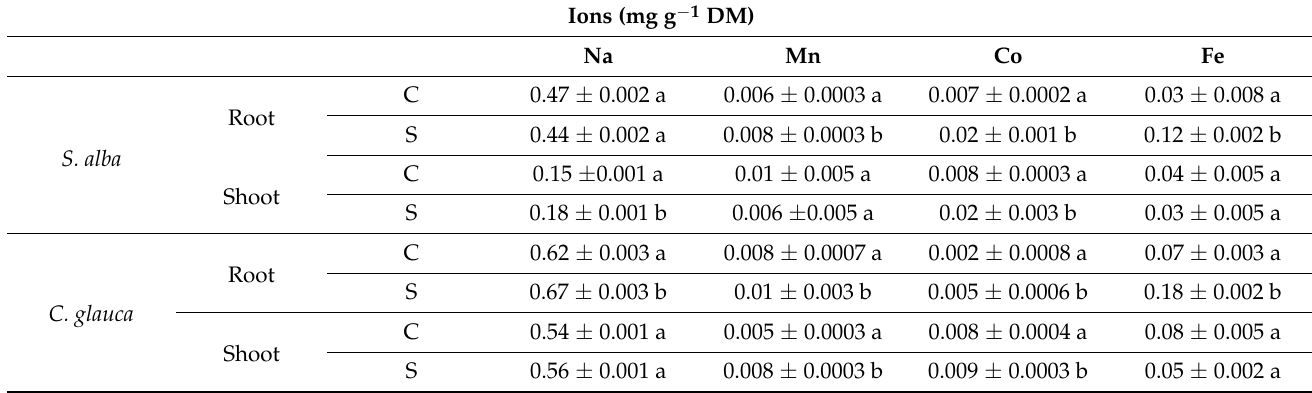
Table 2. Variation in Na, Mn, Co and Fe ion concentrations in the shoot and roots of S. alba and C. glauca seedlings subjected to stress for 35 days imposed by 25% of industrial wastewater (S, stressed treatment) or in optimal conditions with tap water (C, control). Three replications ± SD of each parameter were carried